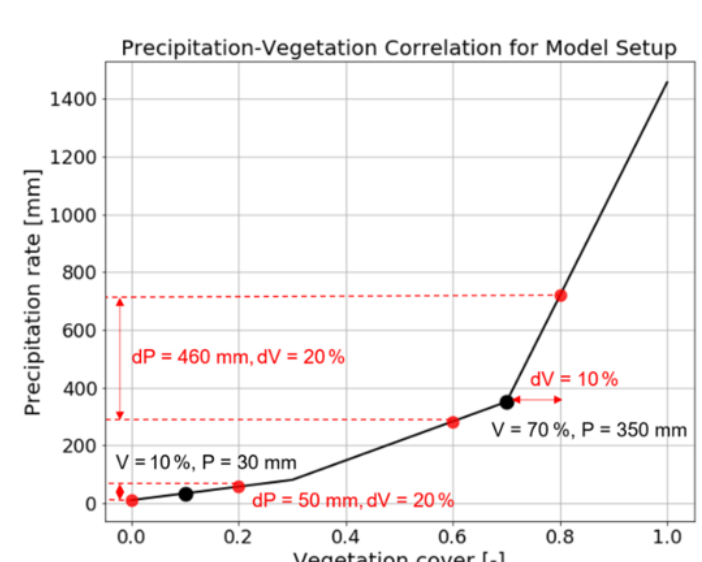
Figure 2. Model geometry as well as climate and vegetation forcings used in this study. (a) A simple representation of the model setup with a square grid, and catchment outlet in the lower left corner. (b) Graphical representation of the magnitude and pattern of fluctuations imposed on vegetation (top) and precipitation (bottom) during the transient state of the model. Red rectangles represent one cycle, whose effects are discussed in detail. (c) Graphical representation of precipitation and vegetation cover correlation from the Chilean study areas used as the empirical basis for how precipitation rates vary for ± 10% changes in vegetation cover (Schmid et al., 2018). https://doi.org/10.5194/esurf-9-1045-2021 Earth Surf. Dynam., 9, 1045–1072,